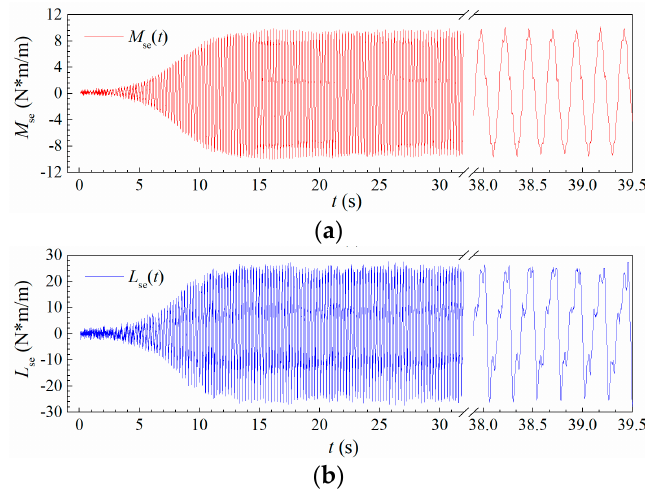
Figure 20. Time histories of the measured aerodynamic ( a ) torsional moment and ( b ) lift (Case B1, U * = 7.785).